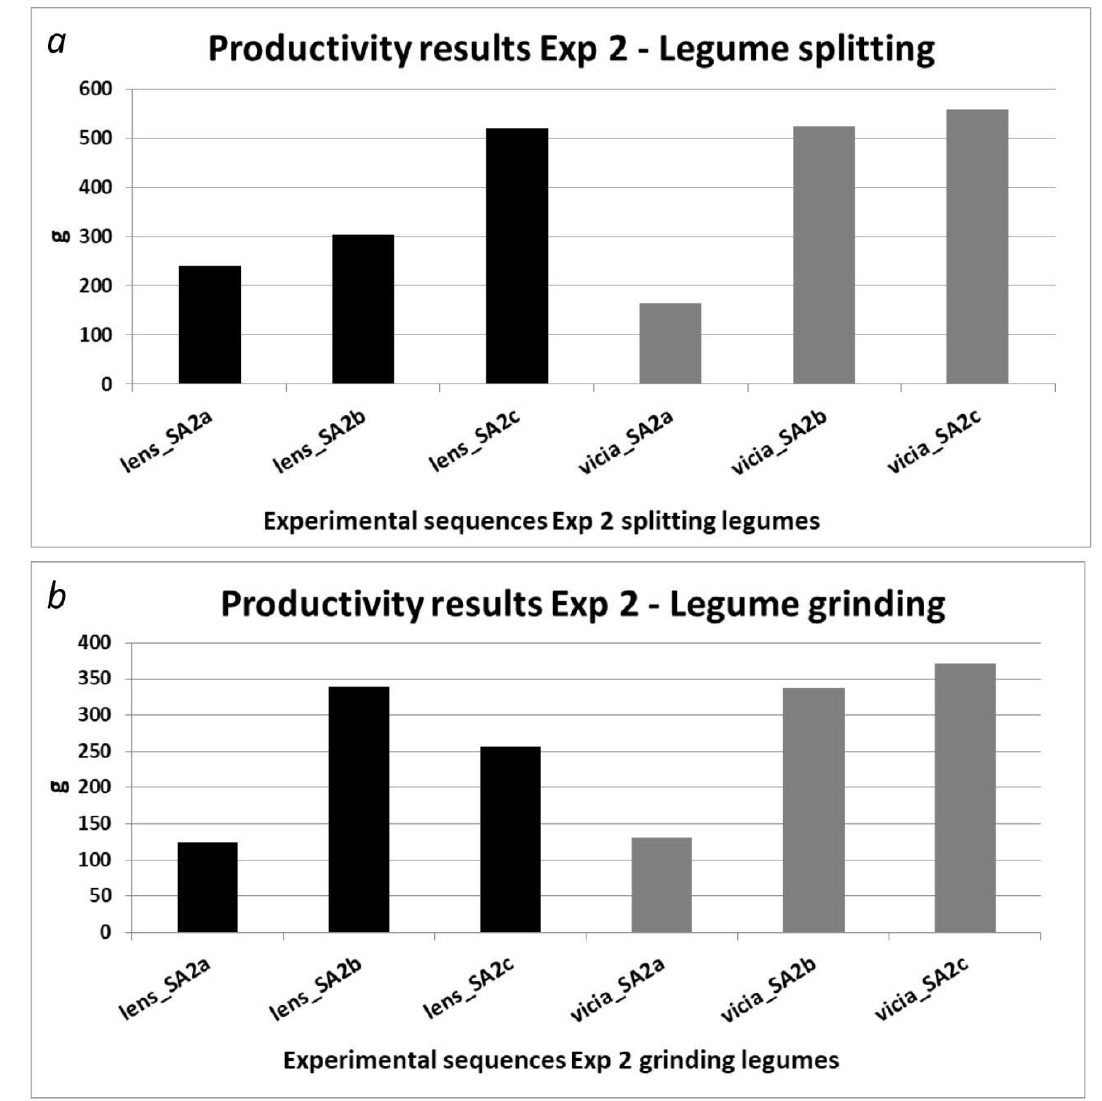
Figure 13 . Results of experiment 2 – splitting (a) and grinding (b) legumes ( Lens culinaris , Vicia ervilia ). Note: All sequences performed with SA2 tool type. Times in all experimental sequences are stable: a= 60 min; b=120 min; c =120 min. The lower results in lens_SA2c were probably due to the user’s